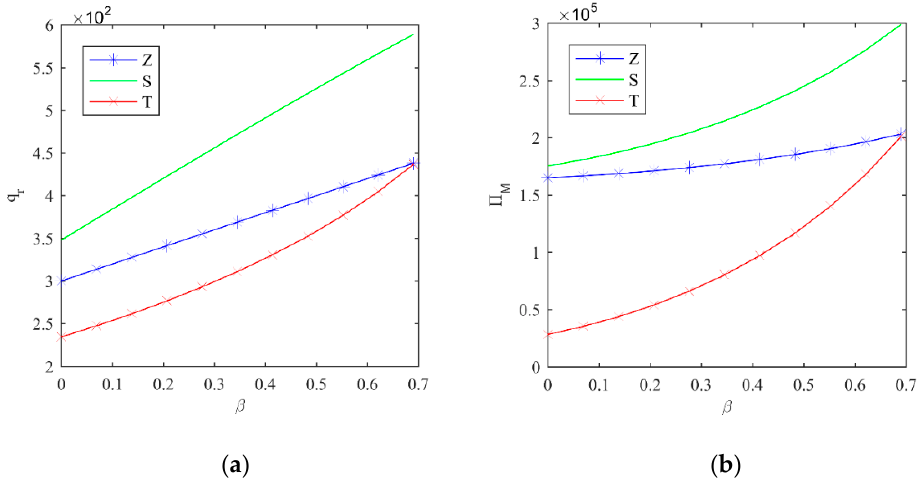
Figure 2. ( a ) Trend of q r with β ; and ( b ) trend of Π M with β